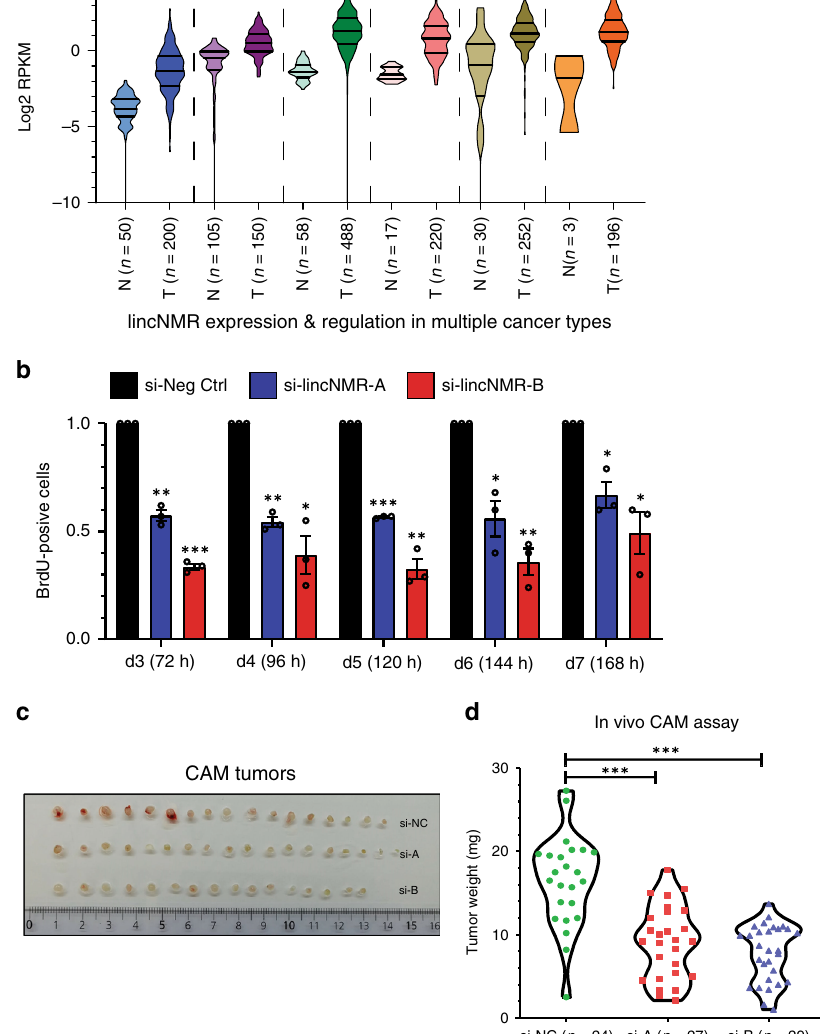
Fig. 2 lincNMR is induced in multiple cancer types and affects tumor growth in vivo. a LincNMR is expressed and regulated in multiple cancer types ( N = normal, T = tumor; data obtained from TCGA data portal). LIHC = hepatocellular carcinoma ( N = 50, T = 200), BRCA = breast cancer ( N = 105, T = 105), LUAD = lung adenocarcinoma ( N = 58, T = 488), LUSC = lung squamous cell carcinoma ( N = 17, T = 220), BLCA = bladder cancer ( N = 30, T = 252), CESC = cervical serous carcinoma ( N = 3, T = 196). Data are represented as log2 RPKM. b Timecourse of BrdU incorporation assays in HLE cells showing induction and maintenance of proliferation inhibition up to 168 h post lincNMR knockdown with 10 nM siPOOLs ( n = 3). Data are normalized to negative control siPOOL. Data represent mean, and error bars represent SEM. c Chick chorioallantoic membrane (CAM) assay: picture showing CAM-harvested tumors formed from HLE cells transfected with lincNMR or control siPOOLs. Tumors were harvested on day 6. LincNMR -depleted cells gave rise to smaller tumors (the number of chick embryos used in total: si-negative control = 24, si- lincNMR -A = 27, si- lincNMR -B = 29). d Quanti fi cation of tumors harvested from CAM assay: decreased tumor weight in lincNMR -depleted tumors compared to the control group. a , b , d Signi fi cance was calculated by unpaired, two- tailed t test with * P < 0.05; ** P < 0.01; *** P <